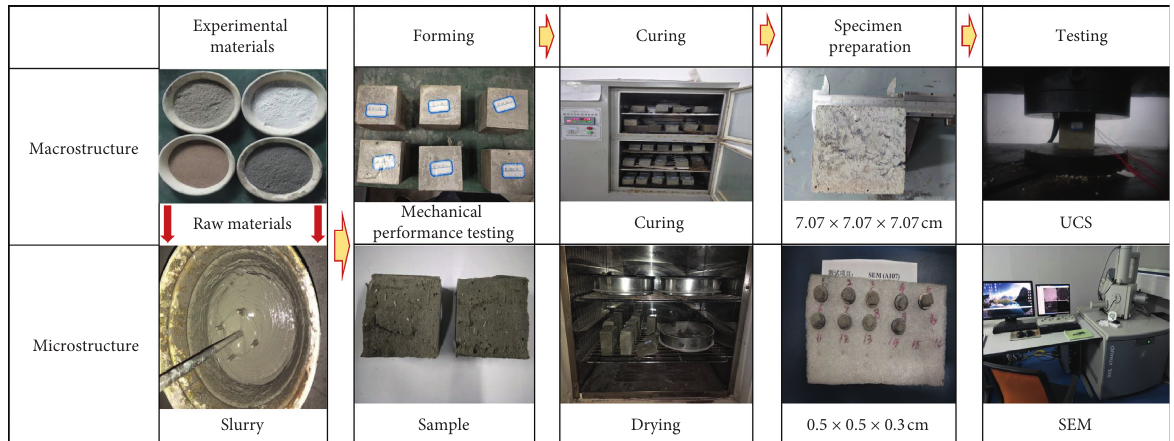
Figure 4: The flowchart of specimen